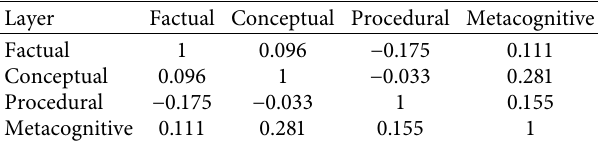
Figure 5: The structure of six communities in a monolayer MKN network Table 5: Interlayer assortativity: Pearson’s correlation coefficients. Layer